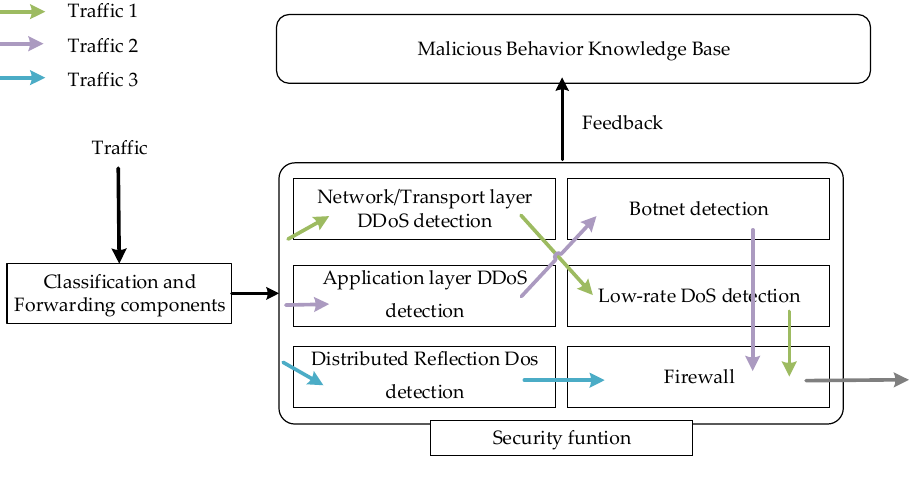
Figure 4. Data layer